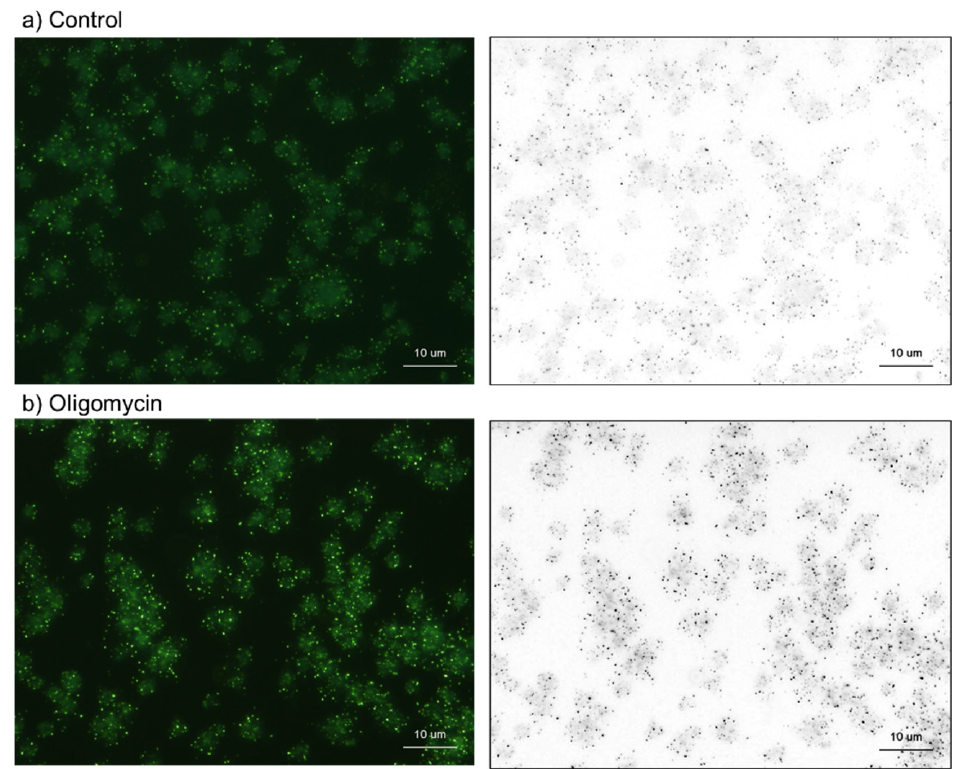
Figure 9. The effects of oligomycin on platelet polyP. Platelets were treated with 10 μ M oligomycin ( b ) for 20 h. The control contained only the solvent (DMSO) ( a ). Bar = 10 μ m. Similar results were observed in four other independent experiments.